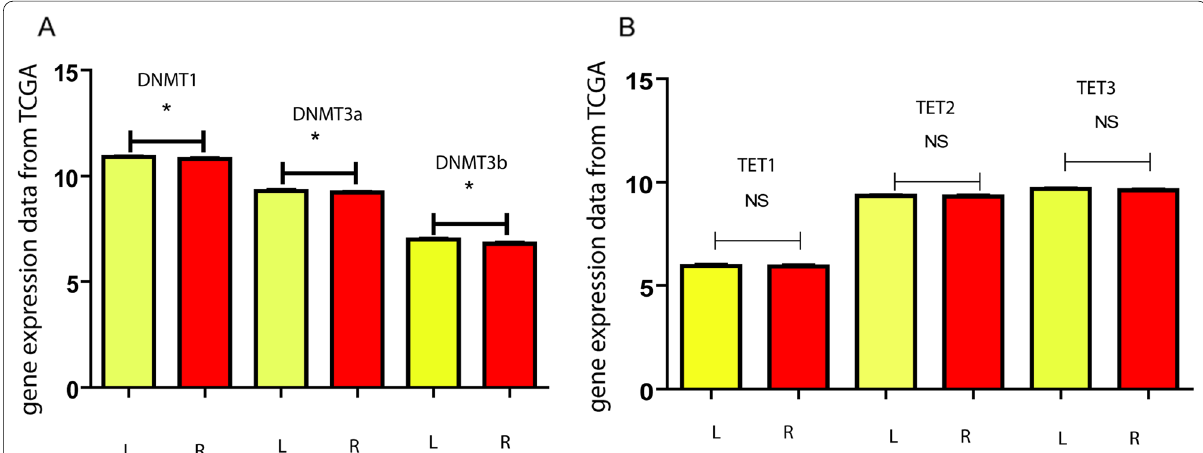
Fig. 6 L–R epigenetic modulators expression comparison. A Gene expression data from 1168 TCGA L–R breast tumors for DNMTs and 1095 for TETs. DNMT s present significant increased expression on L-sided tumors, as compared to the R ones. This is not accompanied by the TET genes ( B ), which do not differ in their expression regarding the side